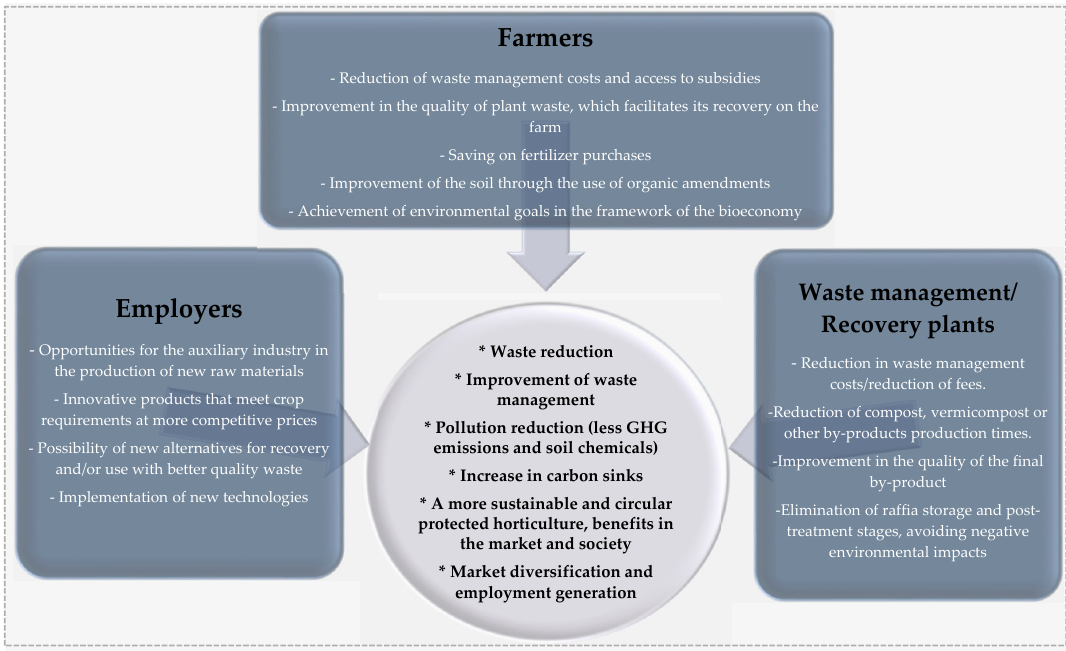
Figure 5. Main advantages and opportunities related to the use of biodegradable raffia. Developed with support from opinions of key players and documentary support [10,33,57,59,63,71,96,101,104,121,130].